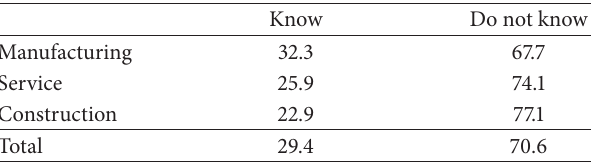
Table 6: Awareness of technology deposit system (%).